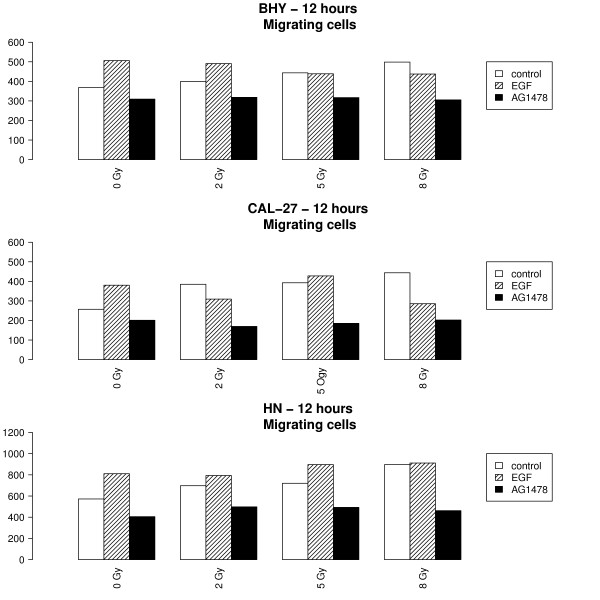
AG1478 inhibits radiation induced migration. Migration ability of the 3 different HNSCC cell lines after stimulation with EGF and blocking of the EGFR with AG1478 was determined by the wound healing assay. The means of 9 tests per dosage were calculated after 12 hrs. The increase of migration with increasing radiation dosis was significantly less pronounced after stimulation with EGF and after blocking of EGFR with AG1478 than in control cells.